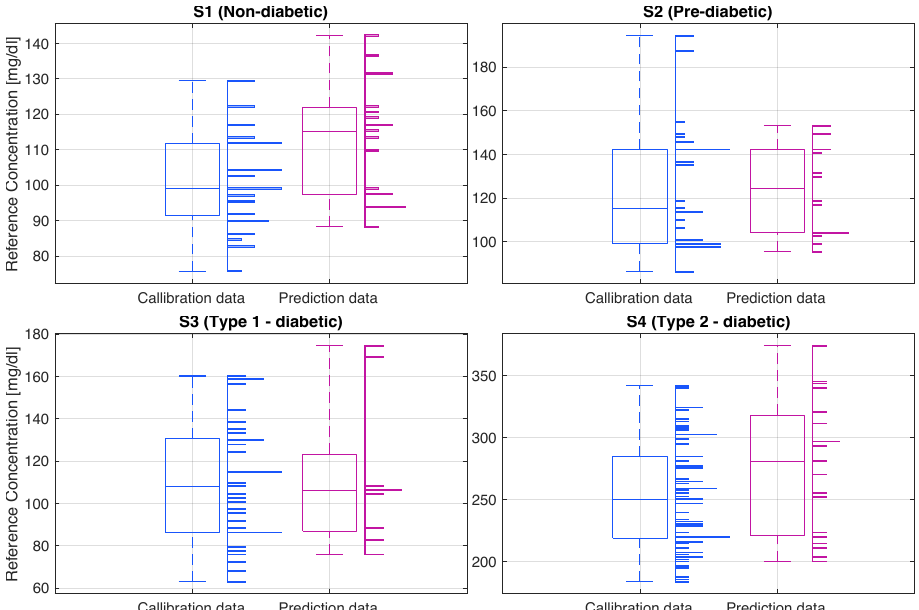
Figure 8. The distribution of the true glucose levels of the calibration and prediction data for each subject (S1–S4), recorded using the gold standard glucometer. Histograms (horizontal bars) show the relative number of measurements at different glucose levels ( y -axis) and the box plots indicate the summary statistics of all recordings for each subject.